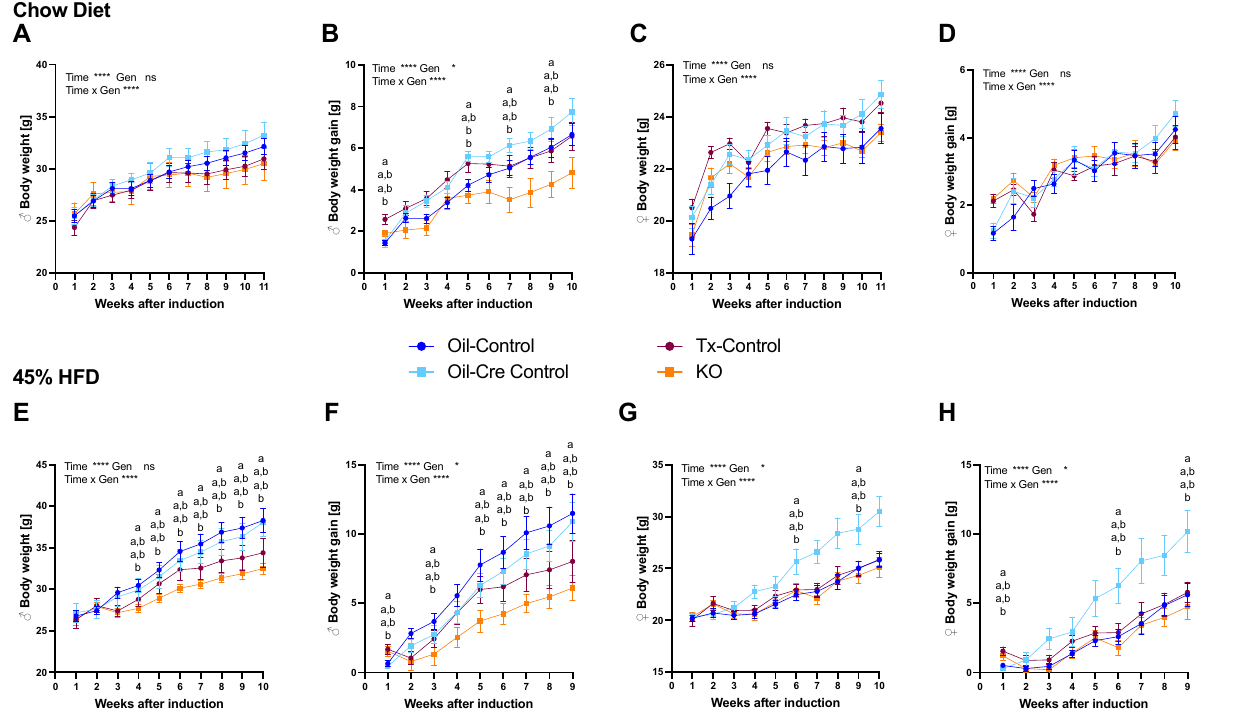
Figure 2. CTR depletion in microglia leads to lower body weight in chow- and HFD-fed male mice. Body weight on chow diet (cohort 2; A , C ) and 45% HFD (cohort 3; E , G ). Cumulative body weight gain after tamoxifen (Tx) or corn oil injection on chow ( B , D ) and 45% HFD ( F , H ). Values are displayed as mean ± SEM; n = 6–10 male mice ( A , B , E , F ) and 8–10 female mice ( C , D , G , H ) per group. Two-way ANOVA with repeated measures (genotype (Gen), time; * p < 0.05, **** p < 0.0001) was used for summary statistics; data points with differing superscript letters (a,b) differ from each other by p = 0.05 or less after Tukey’s post ‐ hoc test.